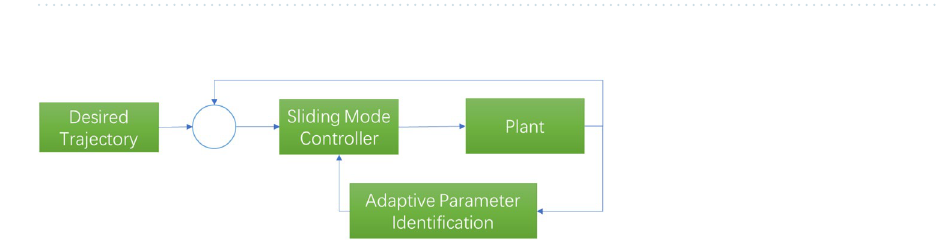
Figure 9. Compound PID controller (CPID).